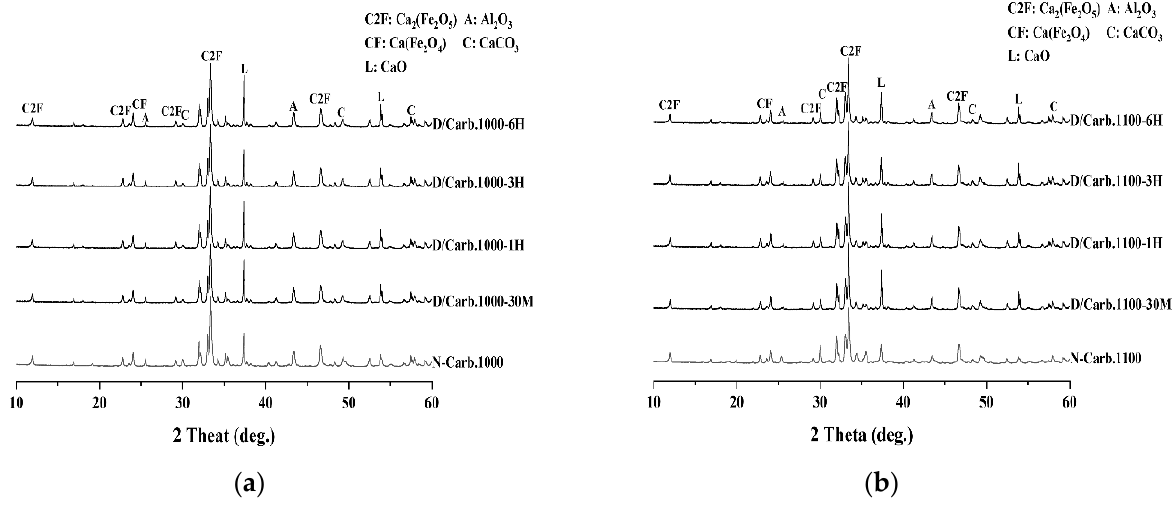
Figure 5. XRD patterns for carbonation with dry method. ( a ) 1000 °C; ( b ) 1100 °C.